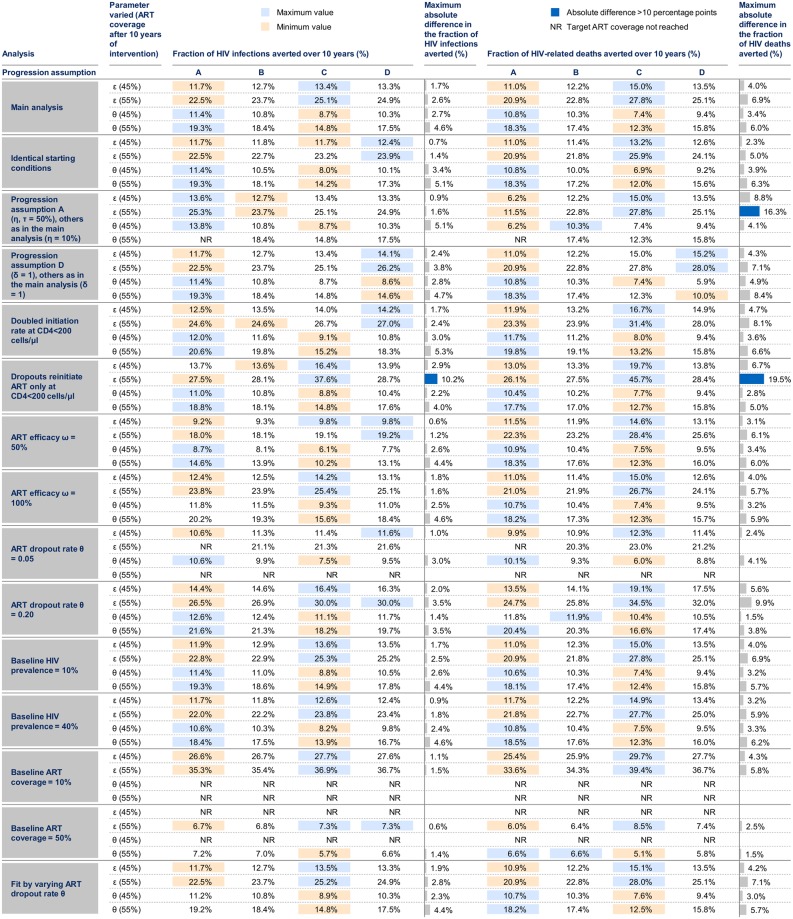
Summary of results.Each model reaches the specified ART coverage target (in brackets) 10 years after the intervention, which is achieved by either increasing the ART uptake rate (ε) or decreasing the ART dropout rate (θ). Maximum absolute differences are the differences between the minimum and maximum estimates across progression assumptions; these are only calculated when estimates are available for all 4 progression assumptions. Blue bars indicate that the absolute difference between progression assumptions in the fraction averted is greater than 10 percentage points. NR: the target ART coverage could not be reached for this progression assumption and the specified intervention.